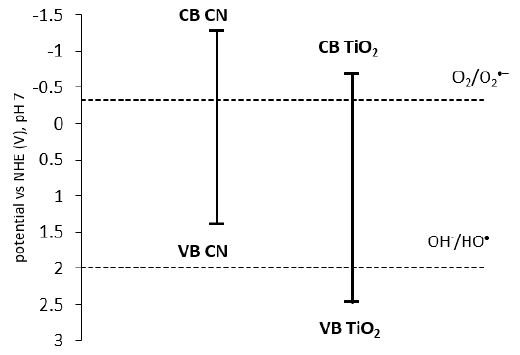
Figure 11. Position of valence-band and conduction-band edge for g-C 3 N 4 and TiO 2 at pH 7 [17].